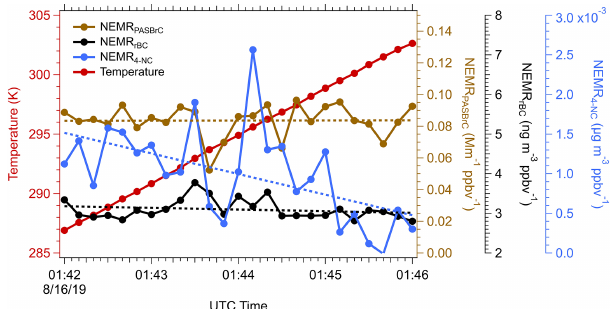
Figure 11. Assessment of volatility of various light absorb- ing species by comparing the time series of NEMR rBC (black), NEMR OA (green), NEMR PASBrC (brown) and NEMR 4-NC (blue), for a measurement period when the temperature (red) increased while sampling within a descending smoke plume from the Sheri- dan fire on 15 August 2019. Dotted lines are trend lines with time fitted by ODR, and p values for all linear regressions are less than 0.1. Data are 10s